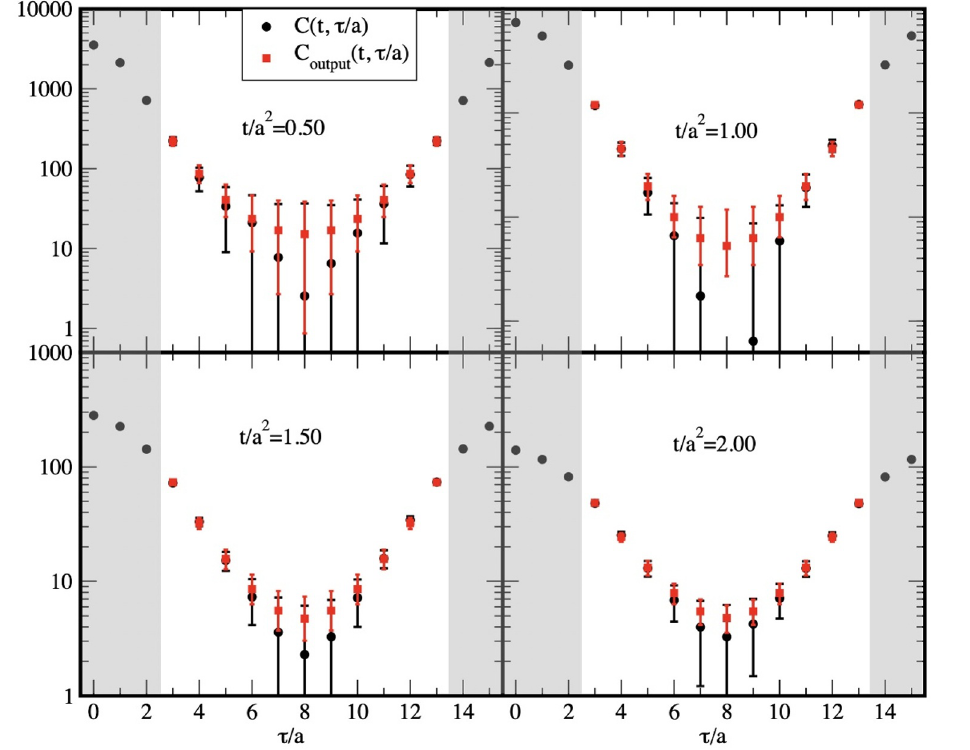
Figure 13 . The comparison between the input correlation function with the Jackknife error and the output one with the bootstrap error. The data C ( t; (cid:28)=a ) in shadowing regime are not utilized in the